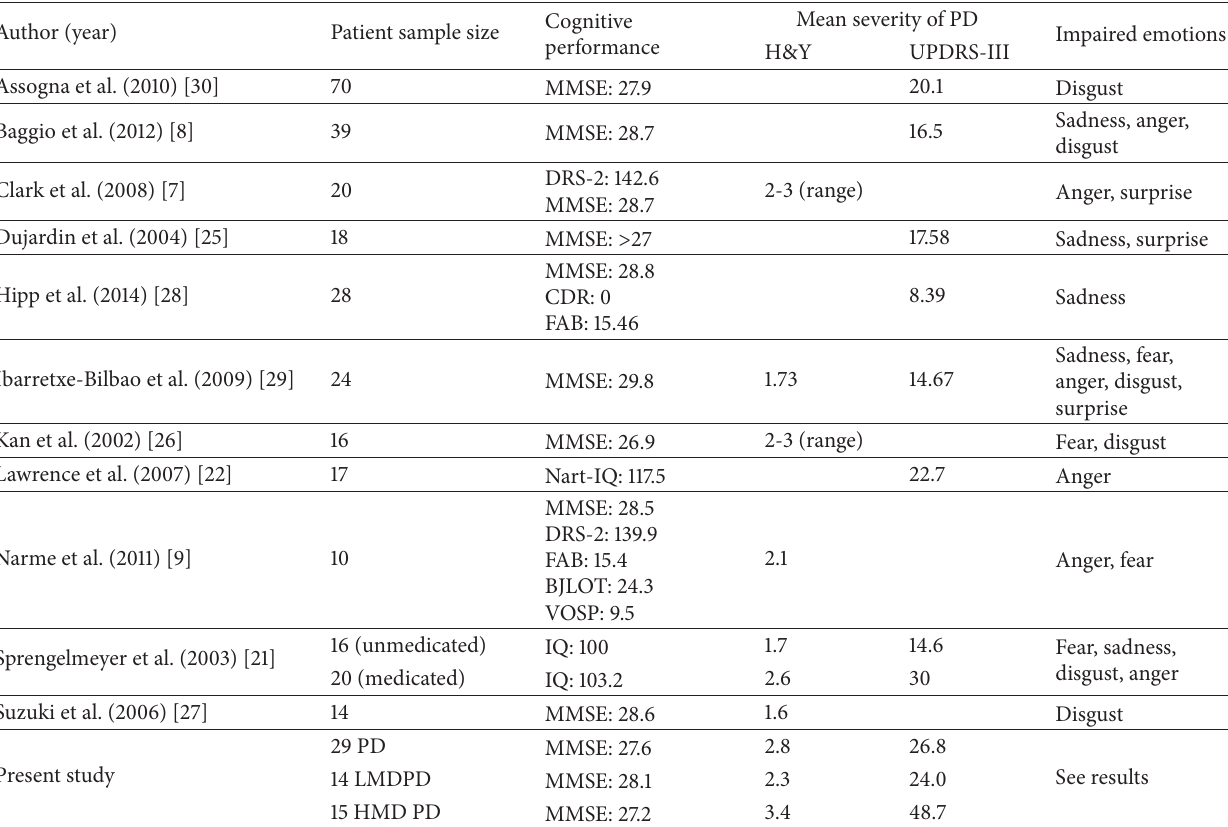
Table 1: Impaired recognition of facial emotion expressions in PD patients.